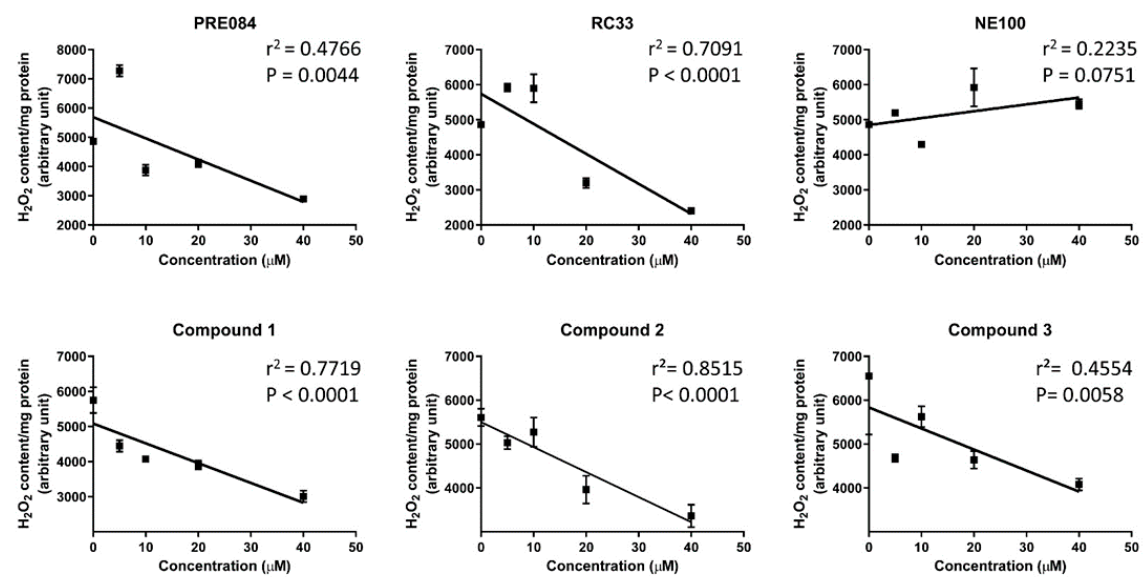
Figure 6. Dose–response effect of compounds Pre084, RC33, NE100, 1 , 2 and 3 on HeLa cells H 2 O 2 content. HeLa cells were heat-stressed at 42 ◦ C for 3 h and pre-treated with increasing concentrations of test compounds. H 2 O 2 was measured using the CM-H2DCFDA reagent (see Materials and methods). Values represent mean ± SD ( n = 4) and are expressed as H 2 O 2 content (arbitrary unit) per mg protein. When not shown, SD were within the symbol area. Overall, linear regression (black line) is presented. p and r 2 values are shown.